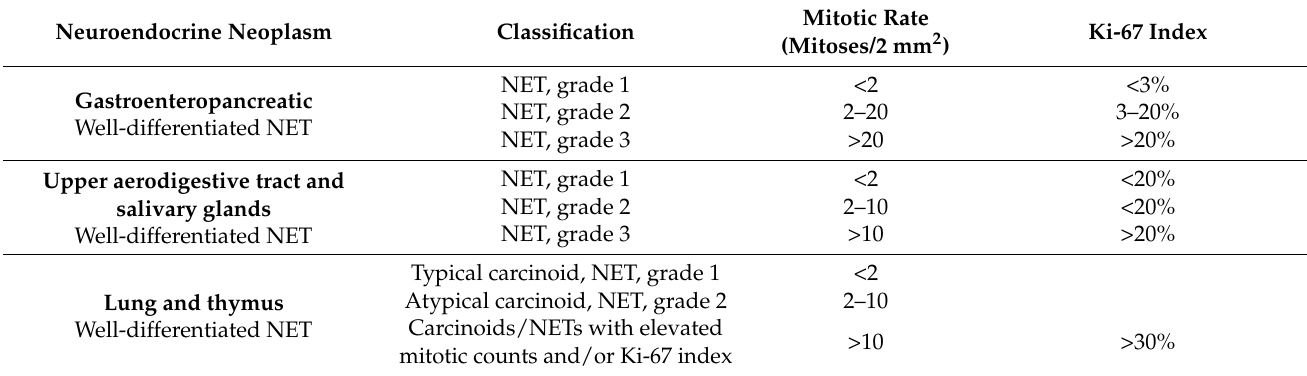
Figure 1. Williams and Sandler provided one of the earlier NET classifications still used today. They divided tumors according to their embryologic site of origin: foregut carcinoids are those arising from the respiratory tract, stomach, duodenum, biliary system, and pancreas; midgut carcinoids arise from the small intestine, appendix, cecum, and proximal colon; and hindgut carcinoids arise from the distal colon and rectum [2]. Table 1. The World Health Organization (WHO) 2022 Classification of Neuroendocrine Neoplasms [3,4].